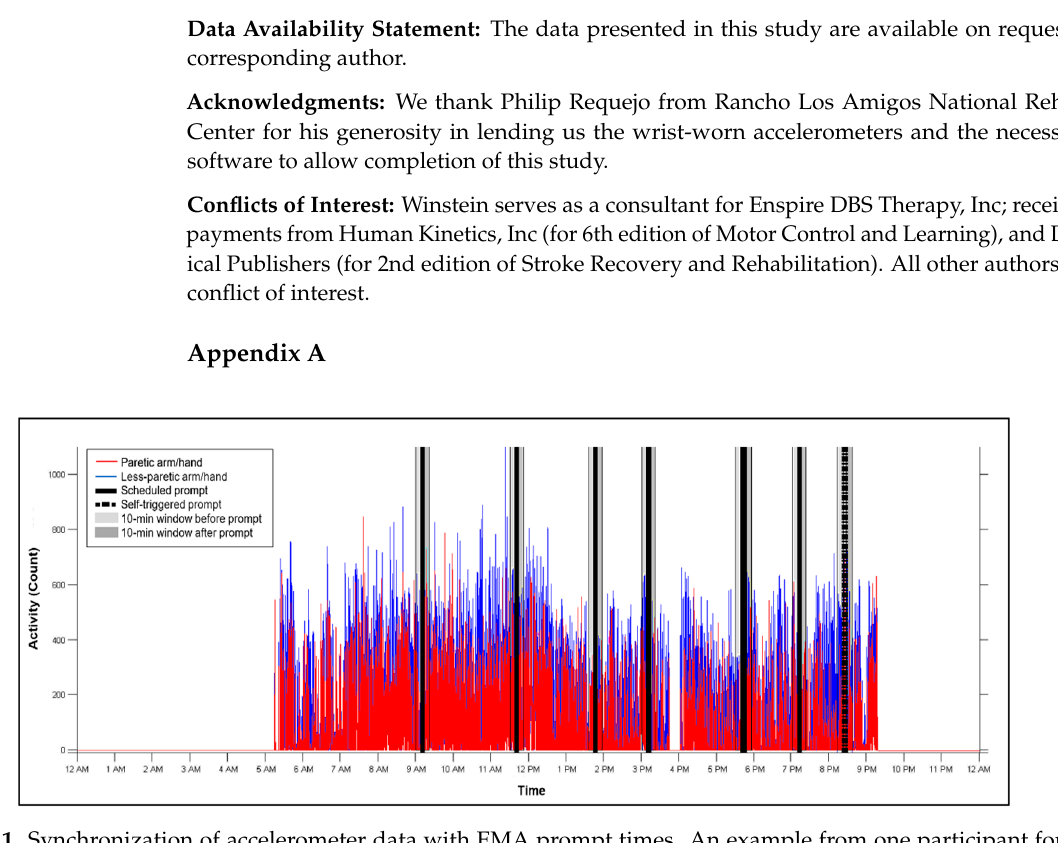
Figure 2. Flow chart of data availability.